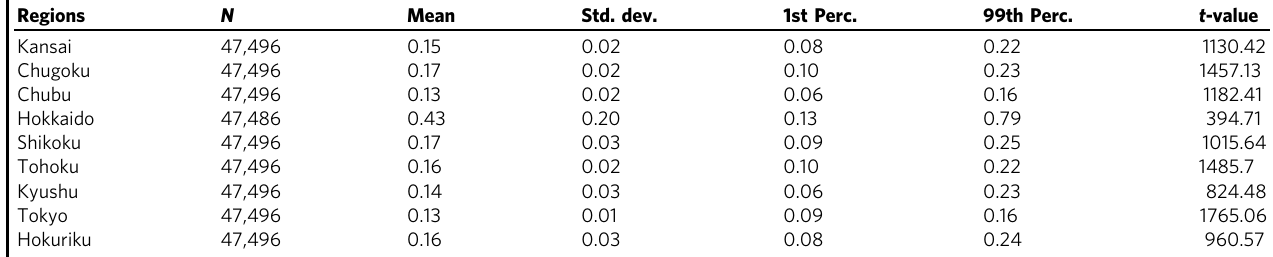
Table 2 Summary statistics of carbon intensity in each region. Regions N Mean Std. dev.